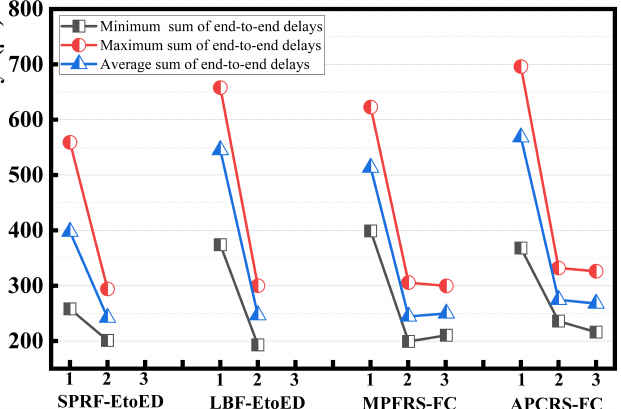
Figure 12. The sum of end-to-end delays of the SPRF-EtoED, LBF-EtoED, MPFRS-FC, and APCRS-FC for 100 test cases with 20 flows, tested in MM